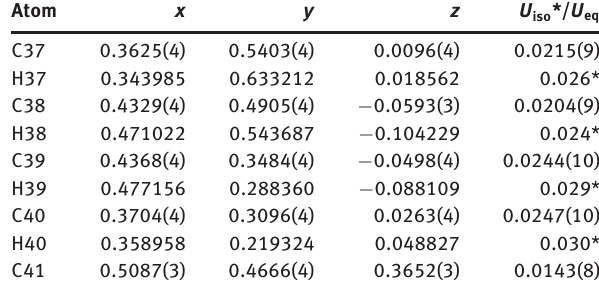
Table 2: Fractional atomic coordinates and isotropic or equivalent isotropic displacement parameters (Å 2